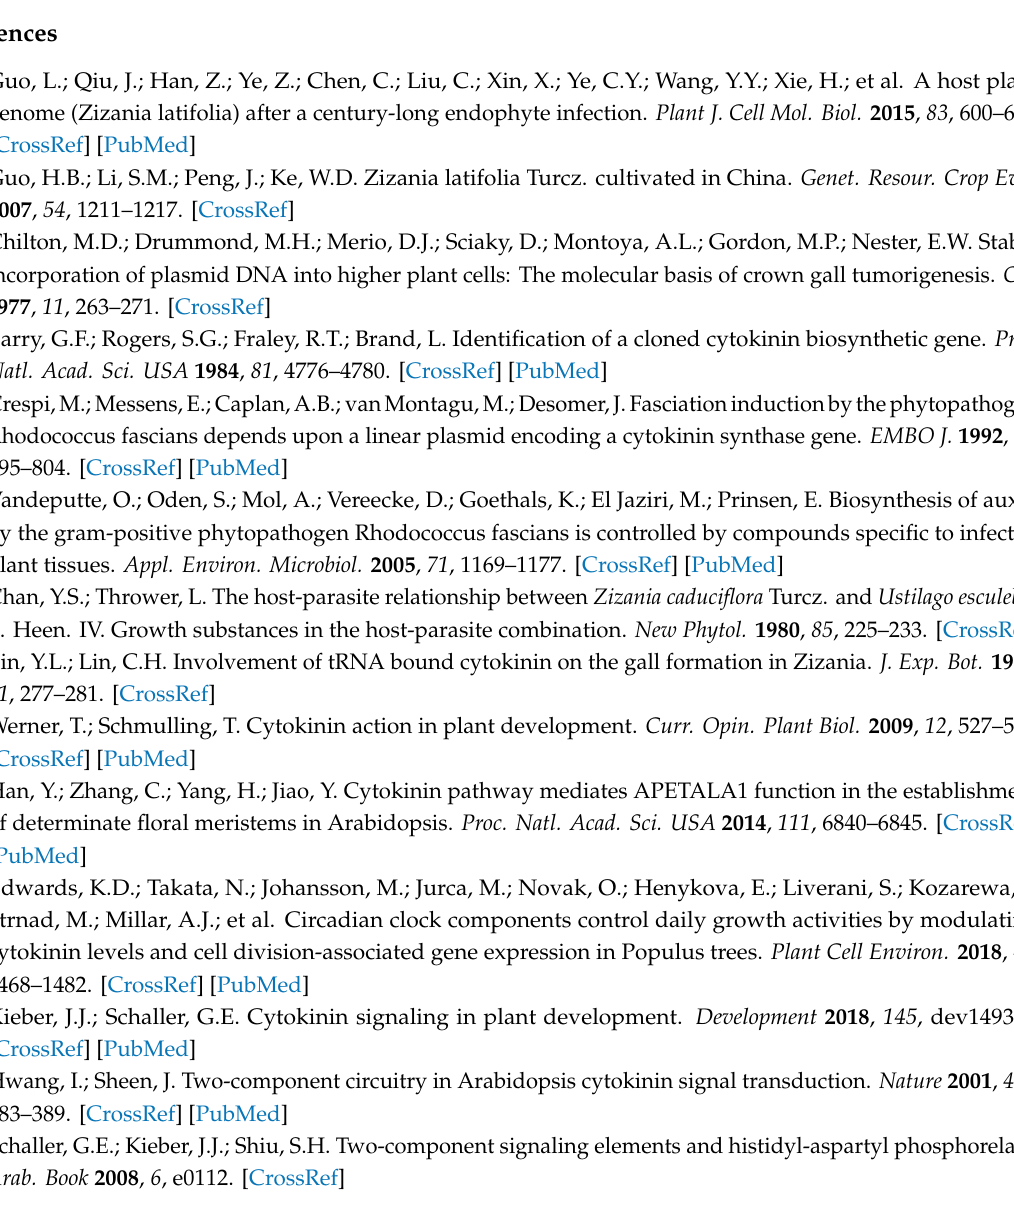
Figure S1: Amino acid sequence alignment of ZlHK(L)s in Z. Latifolia ; Figure S2: Phylogenetic relationship, gene structures, and conserved motif of all HK(L) genes in Z. latifolia ; Figure S3: Phylogenetic relationship, gene structures, and conserved motif of the HP family members in Z. Latifolia ; Figure S4: Amino acid sequence alignment of ZlHP proteins in Z. latifolia ; Figure S5: Phylogenetic relationship, gene structures, and conserved motif of RR genes in Z. latifolia ; Figure S6: The validation of TCS gene expression by qPCR; Table S1: Summary of the two-component system (TCS) gene numbers identified in plants; Table S2: The Ka / Ks ratios of duplicated TCS genes in Z. latifolia ; Table S3: The primer